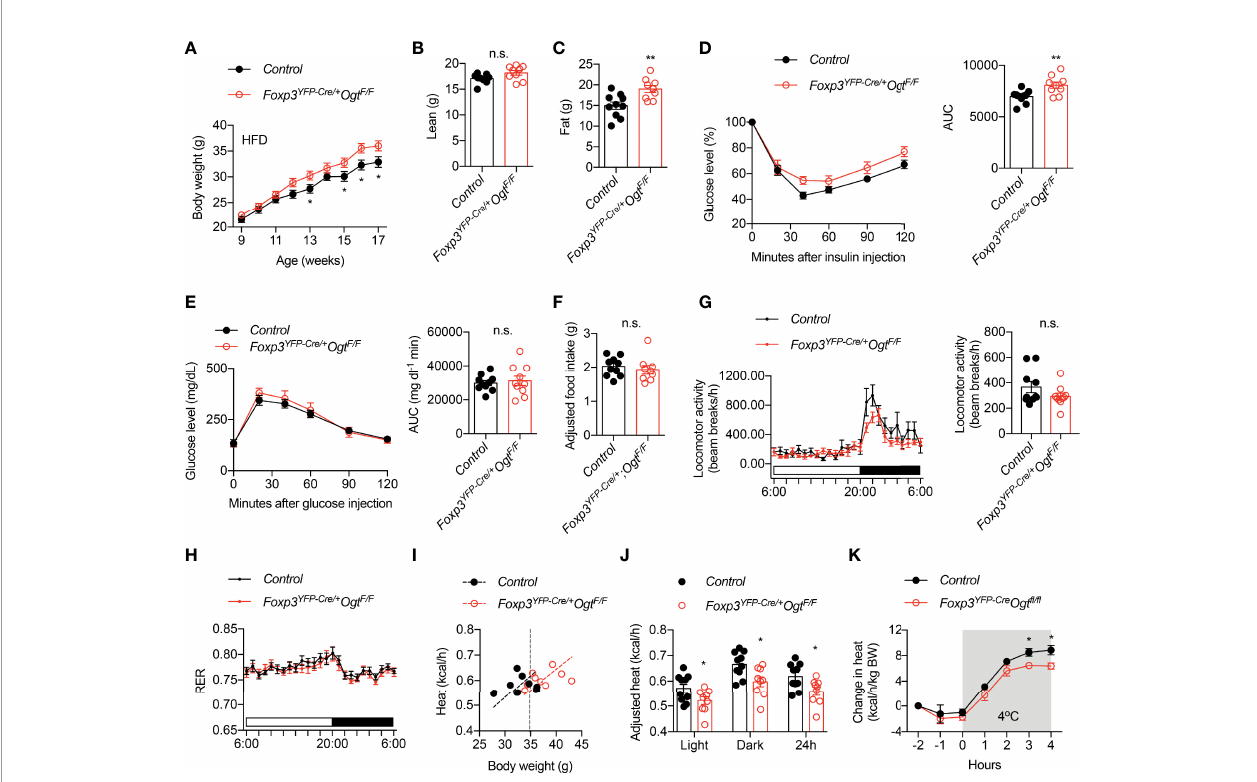
FIGURE 2 | Foxp3 YFP-Cre/wt Ogt F/F mice are prone to diet-induced obesity. (A) Growth curve of Foxp3 YFP-Cre/wt Ogt F/+ (n = 19) and Foxp3 YFP-Cre/wt Ogt F/F (n = 17) female mice after HFD feeding. (B) Lean mass and (C) fat mass of HFD-fed Foxp3 YFP-Cre/wt Ogt F/+ (n = 10) and Foxp3 YFP-Cre/wt Ogt F/F (n = 9) female mice. (D) Insulin tolerance test of HFD-fed Foxp3 YFP-Cre/wt Ogt F/+ (n = 10) and Foxp3 YFP-Cre/wt Ogt F/F (n = 9) female mice. Area under curve (AUC) is shown to the right. (E) Glucose tolerance test of HFD-fed Foxp3 YFP-Cre/wt Ogt F/+ (n = 10) and Foxp3 YFP-Cre/wt Ogt F/F (n = 10) female mice. Area under curve (AUC) is shown to the right. (F) Daily HFD intake of Foxp3 YFP-Cre/wt Ogt F/+ (n = 10) and Foxp3 YFP-Cre/wt Ogt F/F (n = 9) female mice. ANCOVA was used to correct food intake for body weight. (G – J) Metabolic cage study of HFD-fed Foxp3 YFP-Cre/wt Ogt F/+ (n = 10) and Foxp3 YFP-Cre/wt Ogt F/F (n = 9) female mice showing locomotor activity (G) , respiratory exchange ratio (RER, H), and heat (I) . Body weight-adjusted heat analyzed with ANCOVA is shown (J) . (K) Cold-induced change in heat production of HFD-fed Foxp3 YFP-Cre/wt Ogt F/+ (n = 5) and Foxp3 YFP-Cre/wt Ogt F/F (n = 5) female mice. Data are presented as mean ± SEM. n.s., not signi fi cant; *, p < 0.05; **, p < 0.01 by unpaired student ’ s t-test (B – G, J) or two-way ANOVA (A, K)